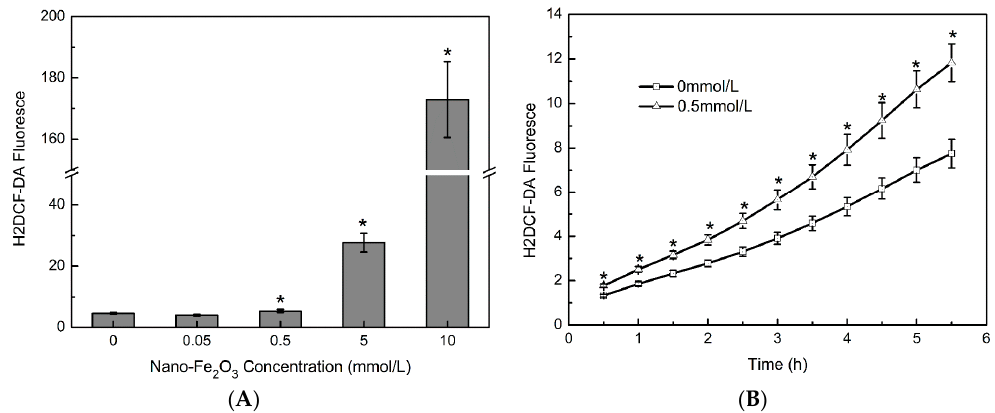
Figure 6. The intracellular level of reactive oxygen species. ( A )The bacteria were exposed to 0, 0.05, 0.5, 5, or 10 mM iron oxide nanoparticles at 25 °C for 2 h in Luria-Bertani (LB) broth. Iron oxide nanoparticles significantly increased the fluorescence of H2DCF-DA (ANOVA, p < 0.05); significant differences between each concentration group and the control (0 mM) were found with the Student–Newman–Keuls (SNK) test, * p < 0.05; ( B ) The bacteria were exposed to 0.5 mM iron oxide nanoparticles for the different times indicated, at 25 °C in LB broth. With prolonged exposure to the iron oxide nanoparticles, the fluorescence of H2DCF-DA significantly increased (ANOVA, p < 0.05); significant differences between each of the iron oxide nanoparticle groups and the control (0 mM) at each time point were found with the SNK test, * p < 0.05.